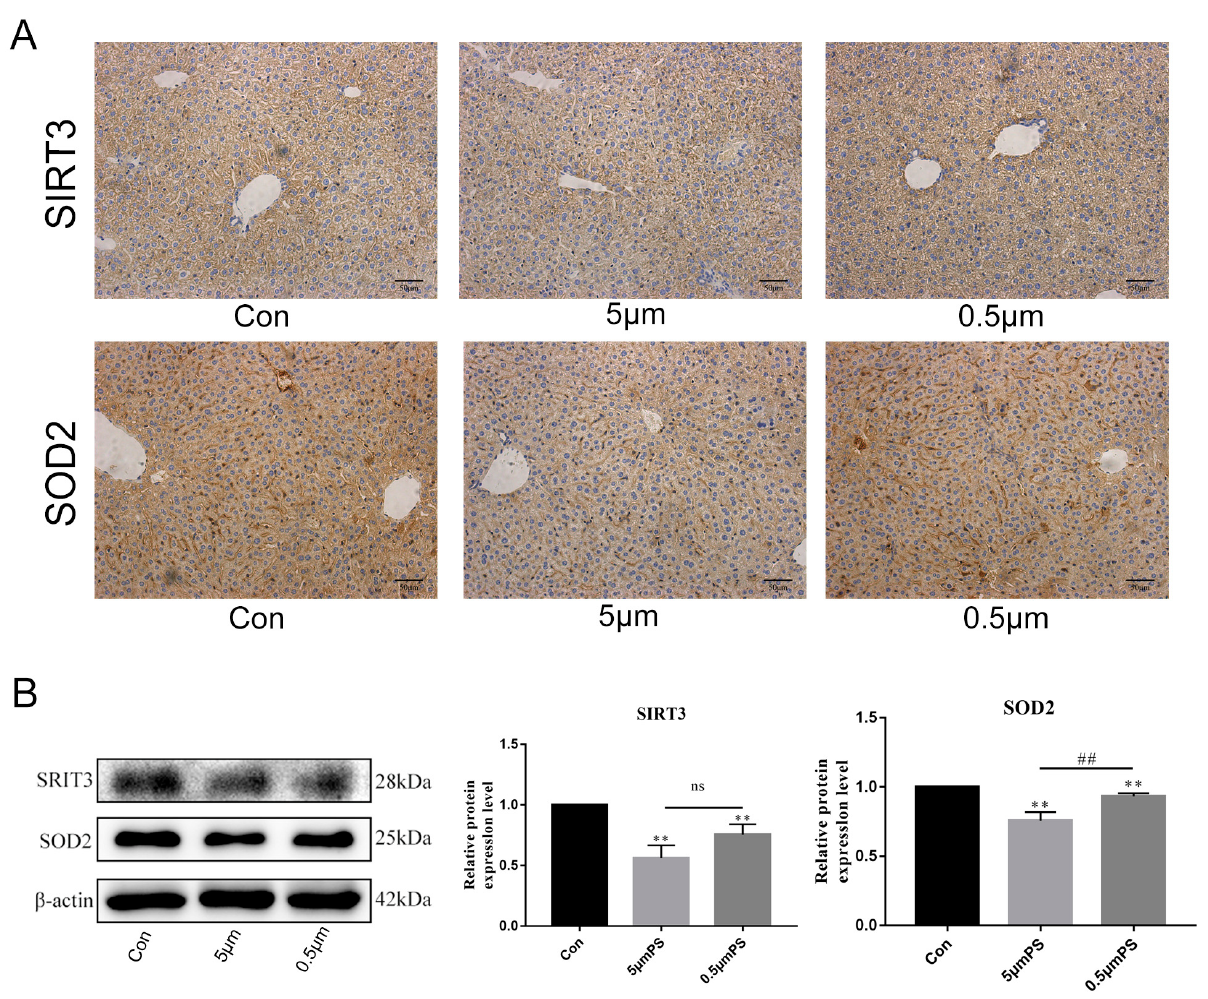
Figure 4. PS-MPs decreased the expression of SIRT3 and SOD2. ( A ) Immunohistochemistry was used to detect the expression of SIRT3 and SOD2 proteins in the liver. Scale bar = 50 µm. ( B ) The levels of SIRT3 and SOD2 were measured using Western blotting, with β -actin serving as an internal control for the cytosolic subfractions. Results are shown as mean ± SD ( n = 3). Compared with the control group, ** p < 0.01. Compared with the 0.5 µm PS-MPs group, ## p < 0.01. ns indicates not statistically signi fi cant.